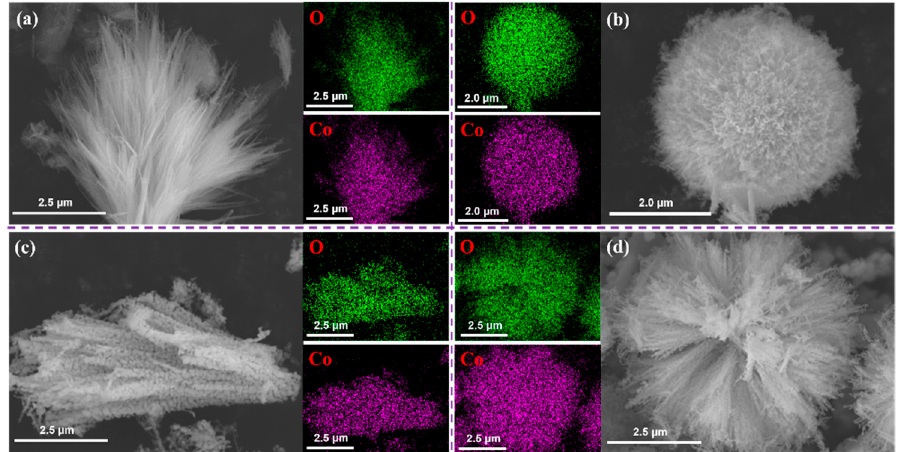
Figure 5. Distribution of elemental cobalt and oxygen corresponding to ( a ) Co 3 O 4 -Cl, ( b ) Co 3 O 4 -SO 4 , ( c ) Co 3 O 4 -AC, and ( d ) Co 3 O 4 -NO 3 .